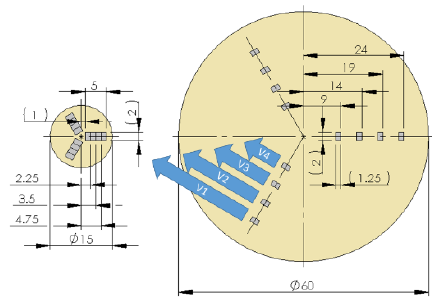
Figure 2. Measurements areas of the GPS analysis: small sample after the SLM process and larger sample after casting.